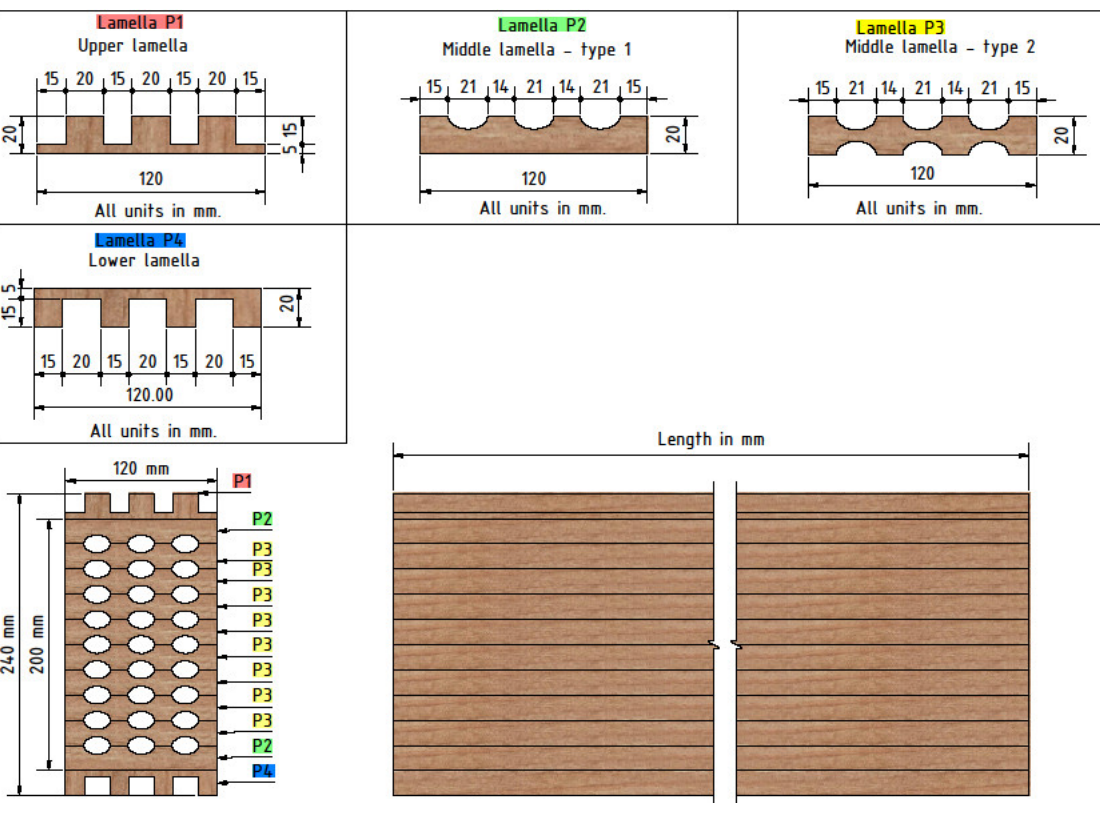
Figure 4. Cube specimens—density measurement. Regarding the geometry (see Figure 5), the cross-sectional dimensions for all specimens were 120 × 240 mm, while the length was as follows: 105, 209, 400, 440, 520, and 640 mm.